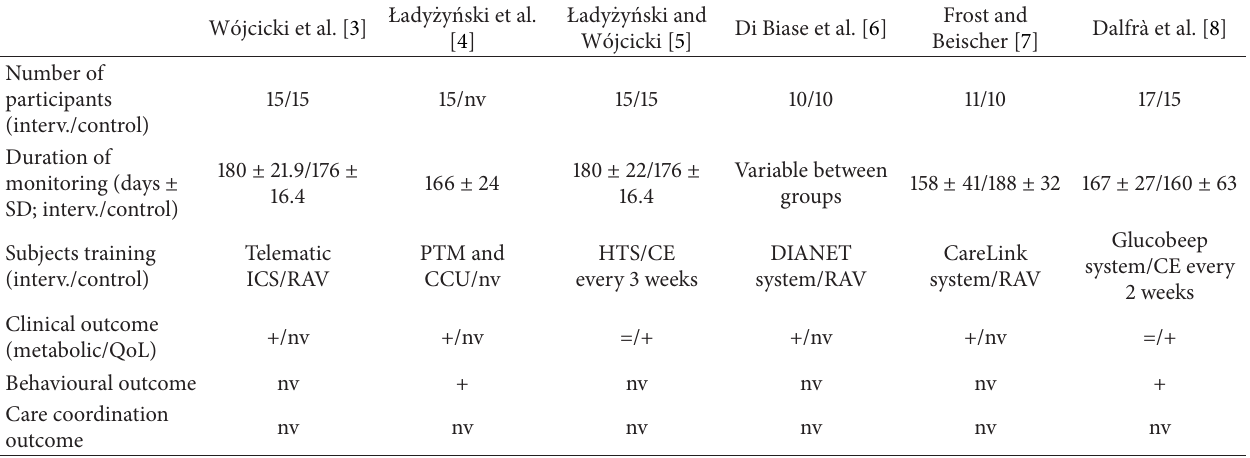
Table 1: Brief summary of the main outcomes of the studies conducted in pregnant women with type 1